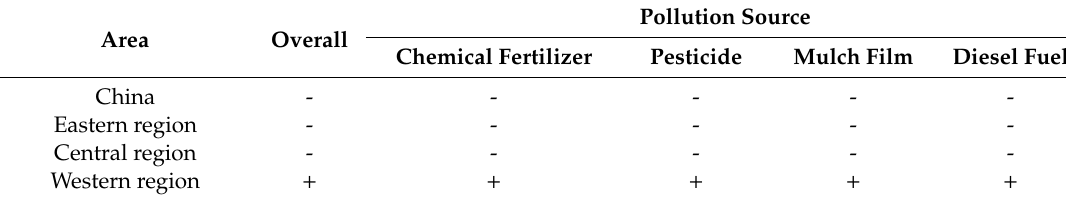
Table 5. The judgment of overall and regional e ff ects. Pollution Source Area Overall Chemical Fertilizer